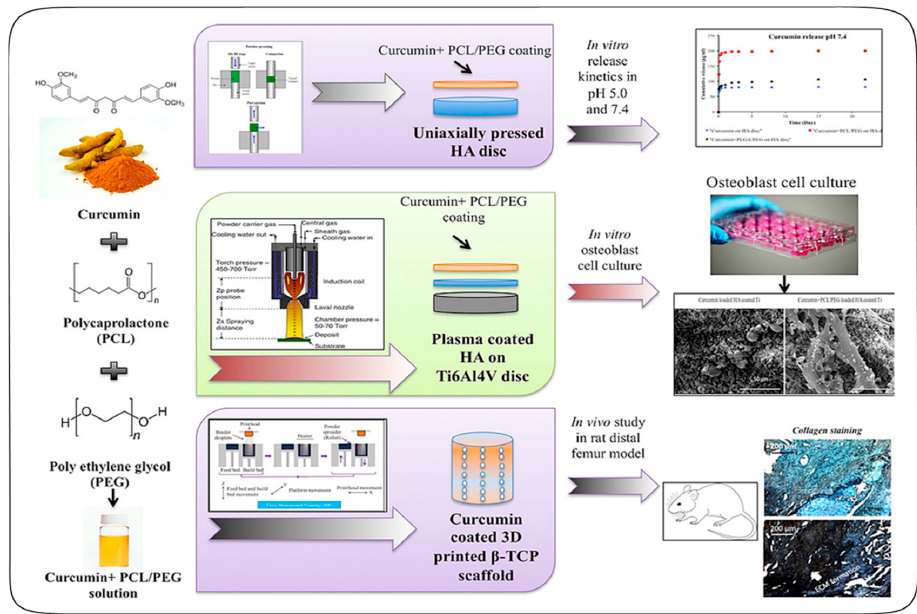
Figure 5. Schematic illustration of the curcumin ‐ polycaprolactone (PCL) ‐ poly(ethylene glycol) (PEG) polymeric system and curcumin ‐ coated 3D printed tricalcium phosphate (TCP) scaffold for in vitro and in vivo bone generation. Reprinted with permission from Ref. [38]. Copyright (2018) Elsevier.